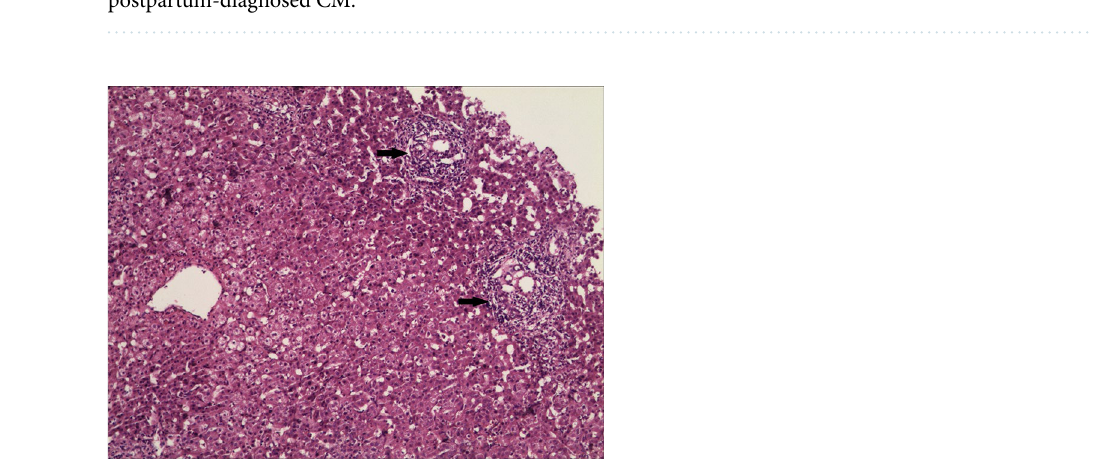
Figure 6. Comparison of biliary tract pathological changes between prepartum-diagnosed CM and postpartum-diagnosed CM.